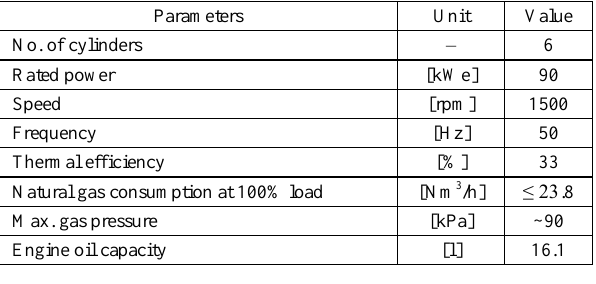
Table 1. Lovol 1006-G6TAG13 parameters